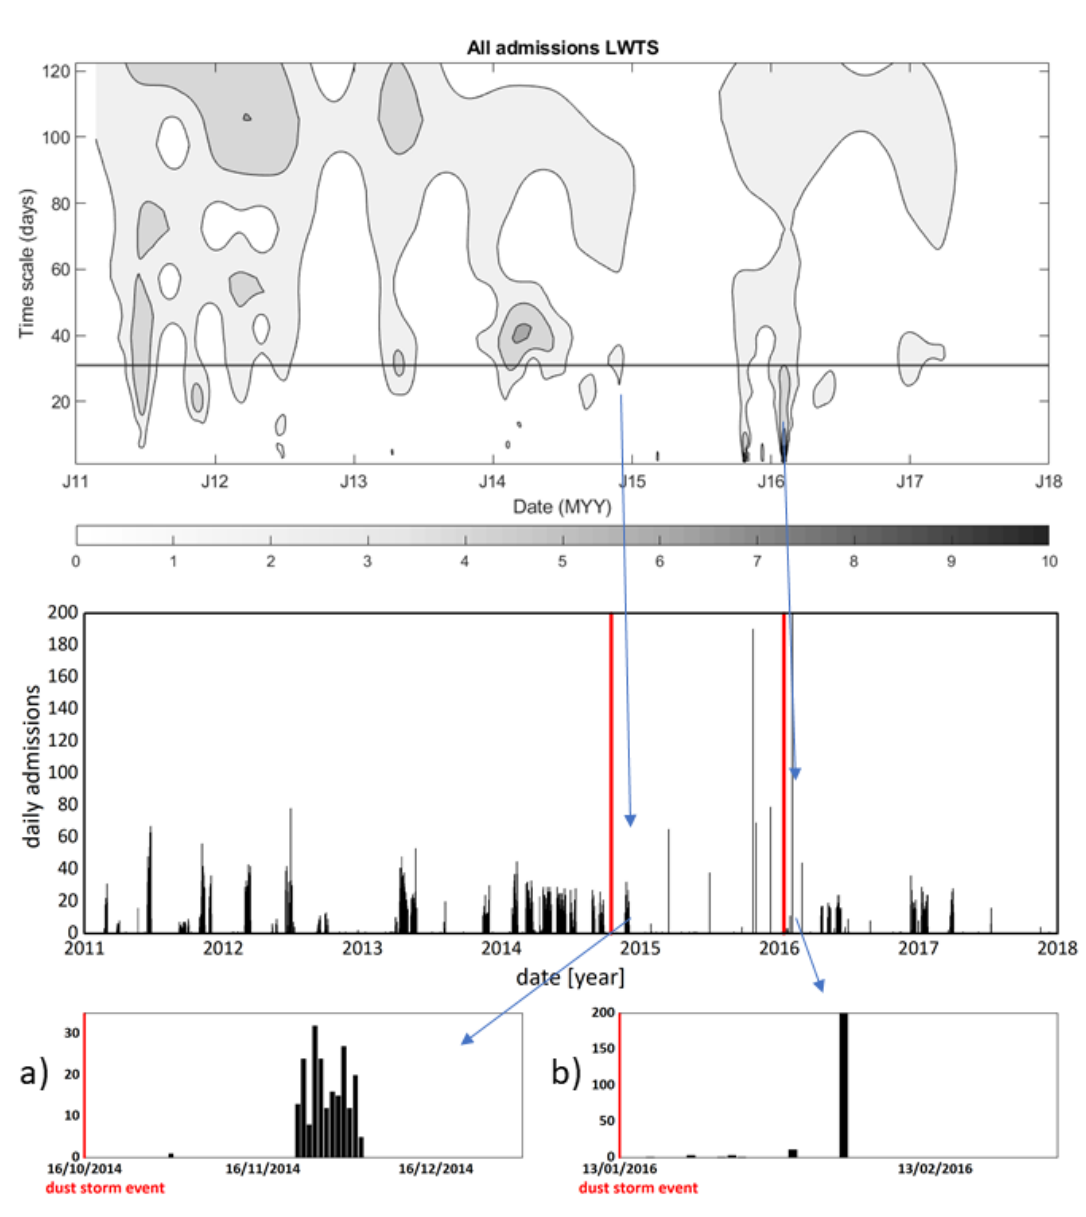
Figure 2. Top row: LWTS data, and Middle row: raw data of the hospital admissions records. Horizontal line at the time scale of 31 days (one month) in LWTS is given as a visual guide. Blue arrows connect changes in LWTS that appear at dates of dust storms with changes in all admissions data that appeared after the dust storm events. These changes are further connected with blue arrows to the corresponding outsets: Bottom row ( a ); and Bottom row ( b ): the admissions original record that present only groups of admissions that may be related to dust storms. Red vertical lines in the raw data graph and the outsets graphs indicate the dates of the dust storm events.